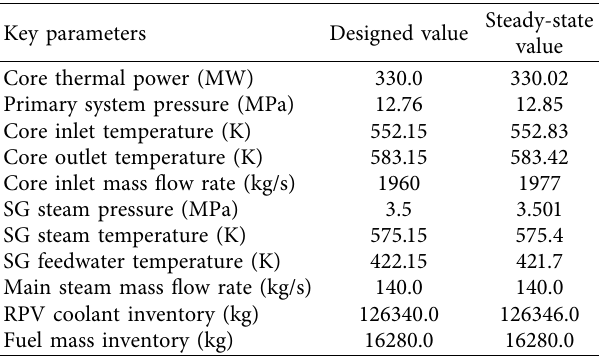
Table 1: Key parameters in steady state and design value.